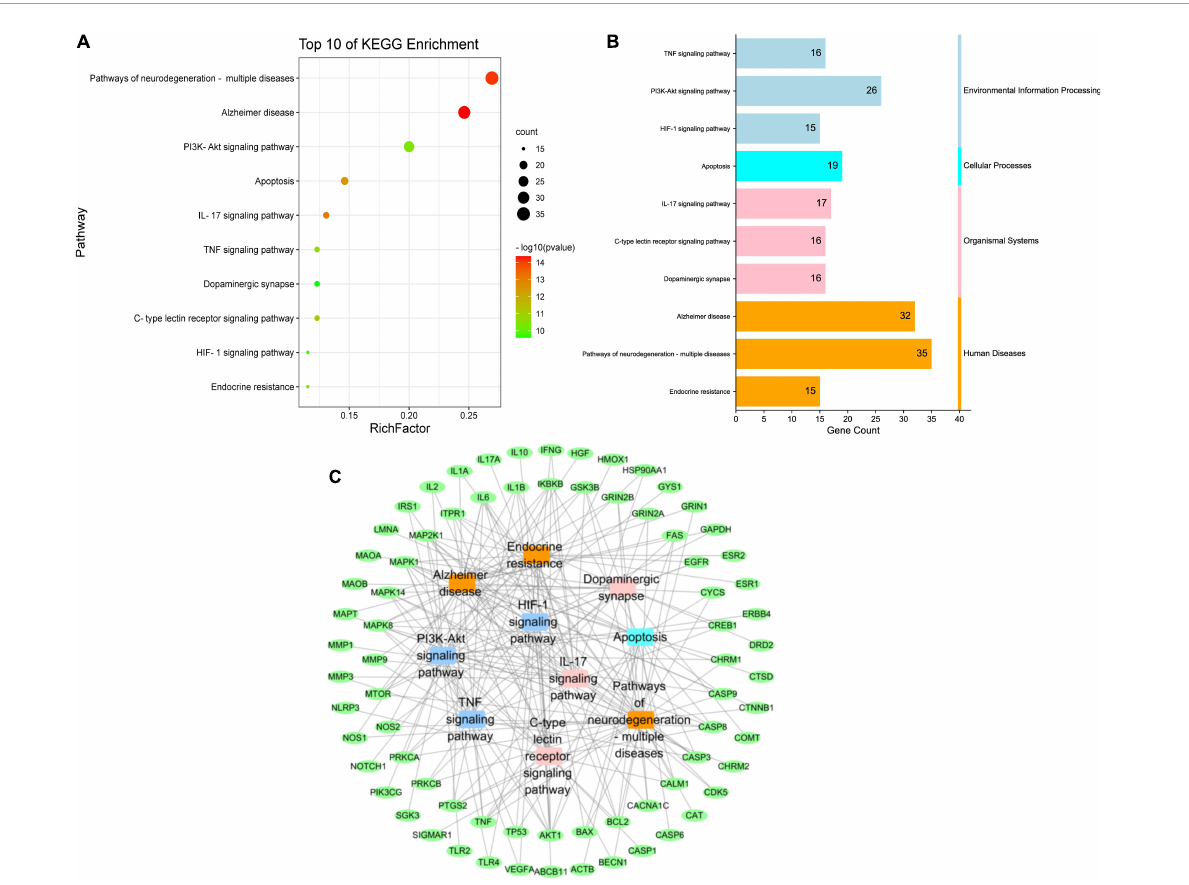
FIGURE6 KEGG pathway enrichment analysis of putative targets of QZZD. (A) Bubble diagram of the top 10 pathways. (B) KEGG pathway classification. (C) Target-pathway network. Green nodes refer to target proteins. Dark blue nodes represent pathways of environmental information processing. Light blue node represents pathway of cellular processes. Pink nodes represent pathways of organismal systems. Orange nodes represent pathways of human